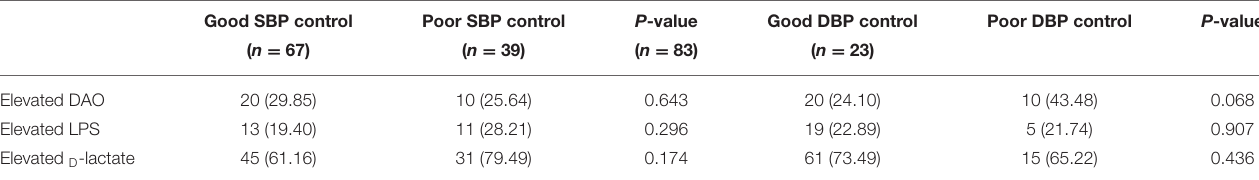
TABLE 5 | Intestinal barrier functions in patients with good or poor control of blood